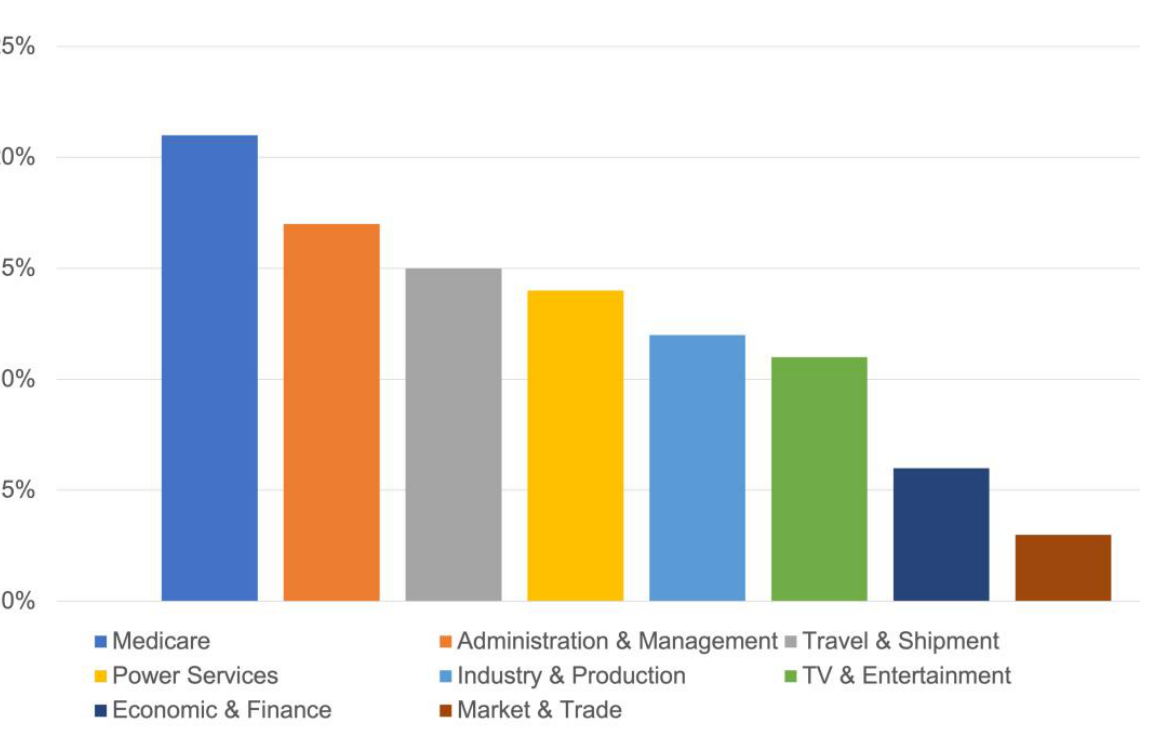
Figure 3. The view of end-user NS market.